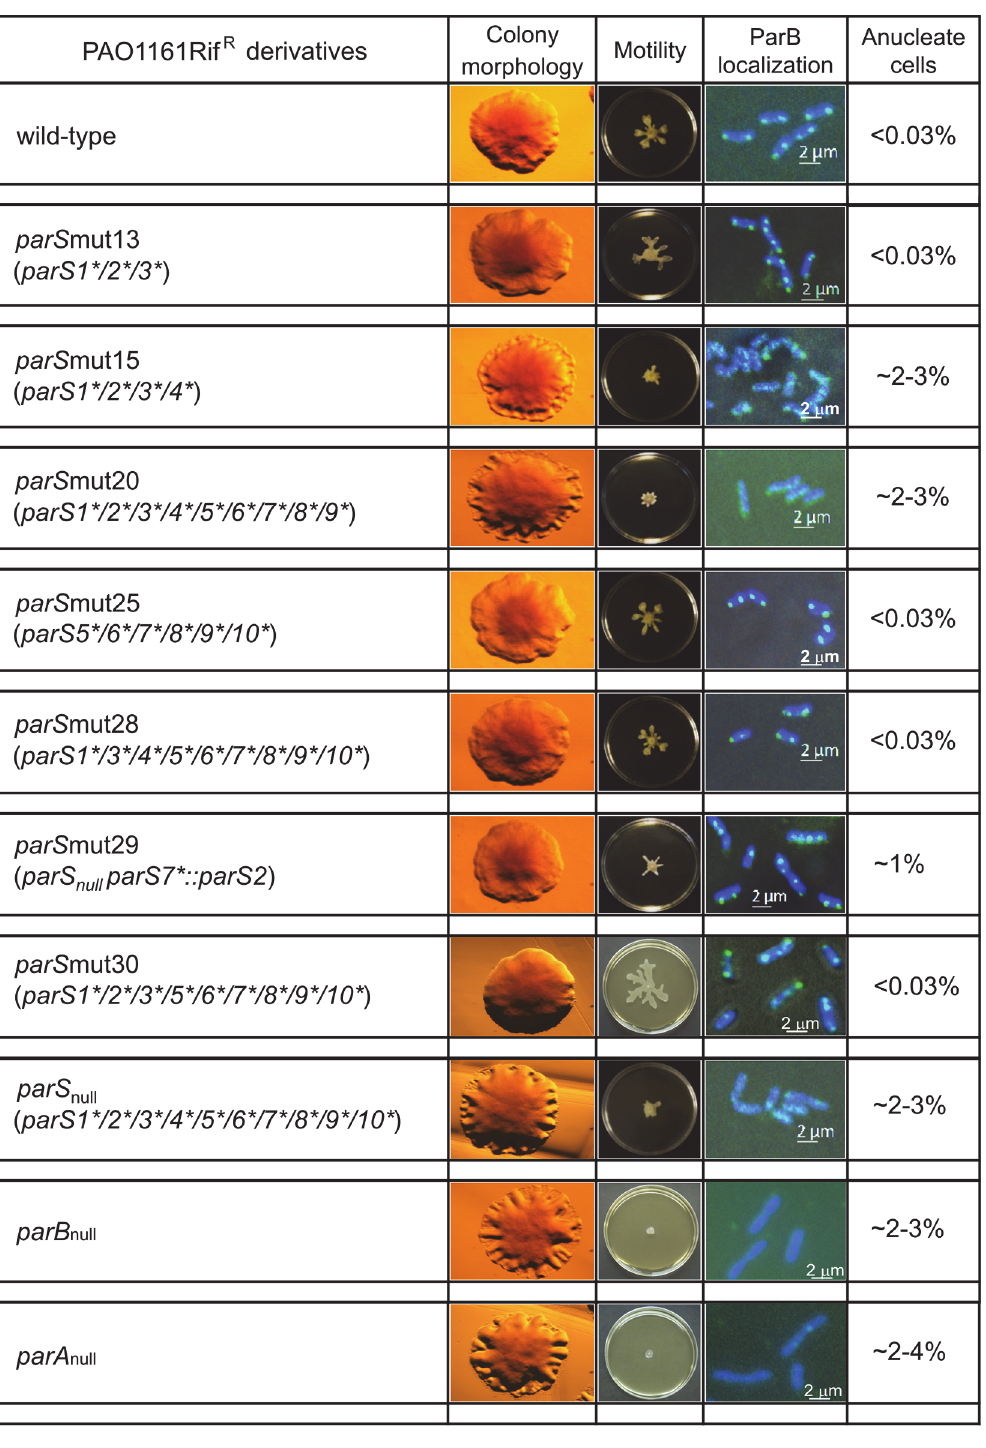
Fig 6. Phenotypes of selected PAO1161 parS mutants. Colony morphology, swarming motility, intracellular ParB localization with the use of FITC- conjugated anti-ParB antibodies, and proportion of anucleate cells after DAPI staining are shown for representative mutant strains. As the controls wt PAO1161 Rif R and parA null and parB null mutants were tested in each set of experiments. The percentage of anucleate cells is the mean from at least three independent experiments, with approximately 1000 cells counted in each experiment.